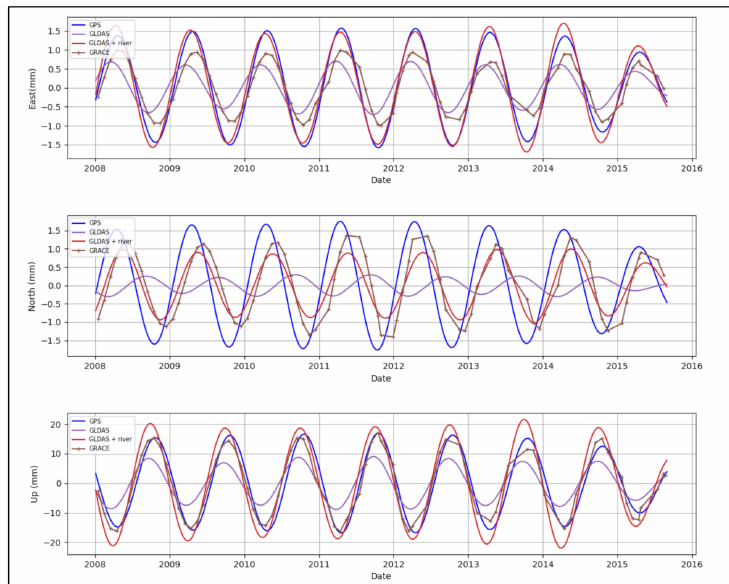
Figure 6. Example of annual signal (RC1, in mm) extracted by M-SSA at station POVE (Porto Velho, Brazil) for East, North, and Up components, respectively. The blue line is the RC1 estimated from the GPS cleaned time series compared to the loading model time series inferred from GRACE (in brown), ATMMO+GLDAS/Noah (in purple), and ATMMO+GLDAS/Noah adding the river contribution (in red).